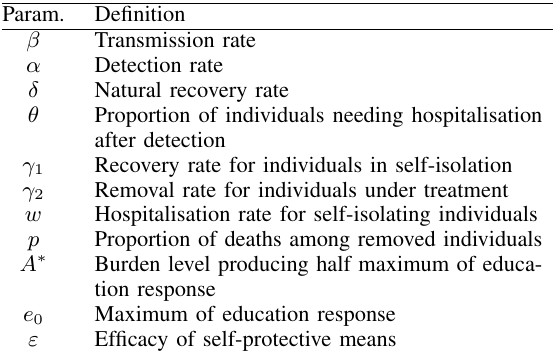
Table II: Definition of parameters.